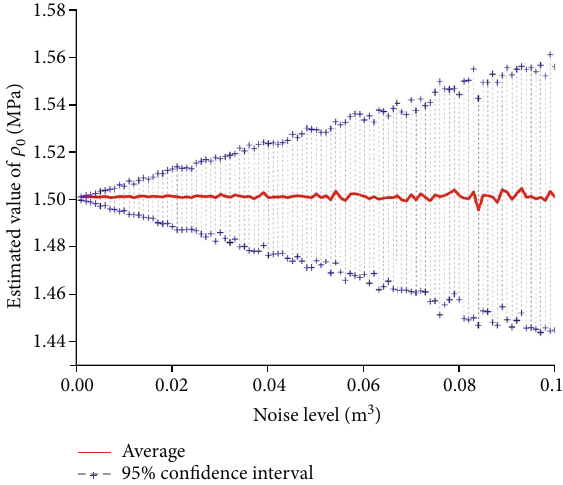
Figure 6: The distribution of estimated initial underbalance pressure at di ff erent noise levels.